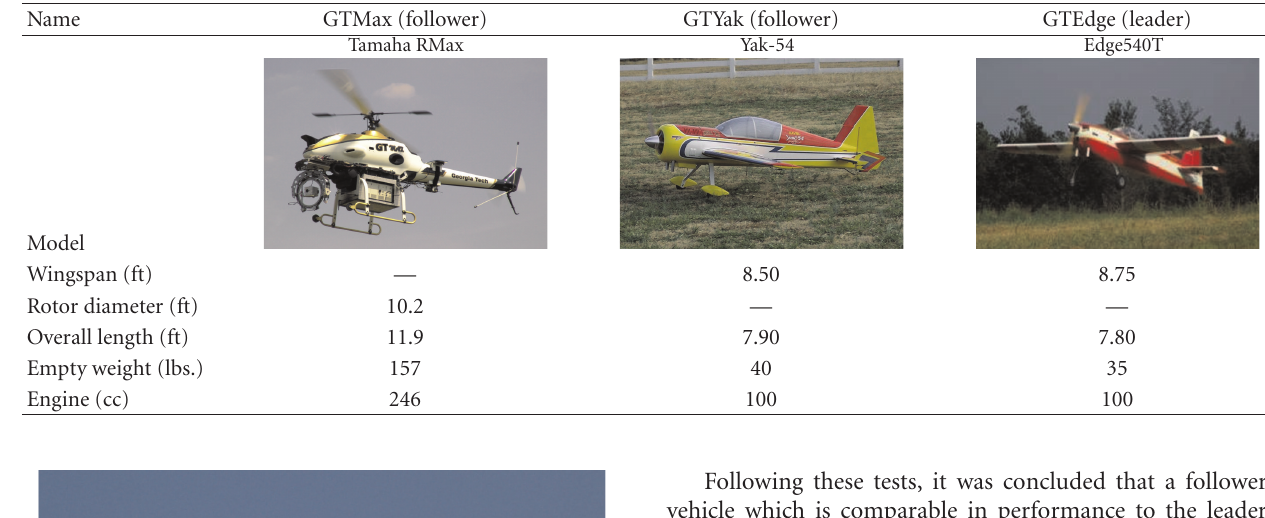
Table 1: Some specifications of UAV’s used for formation flights.